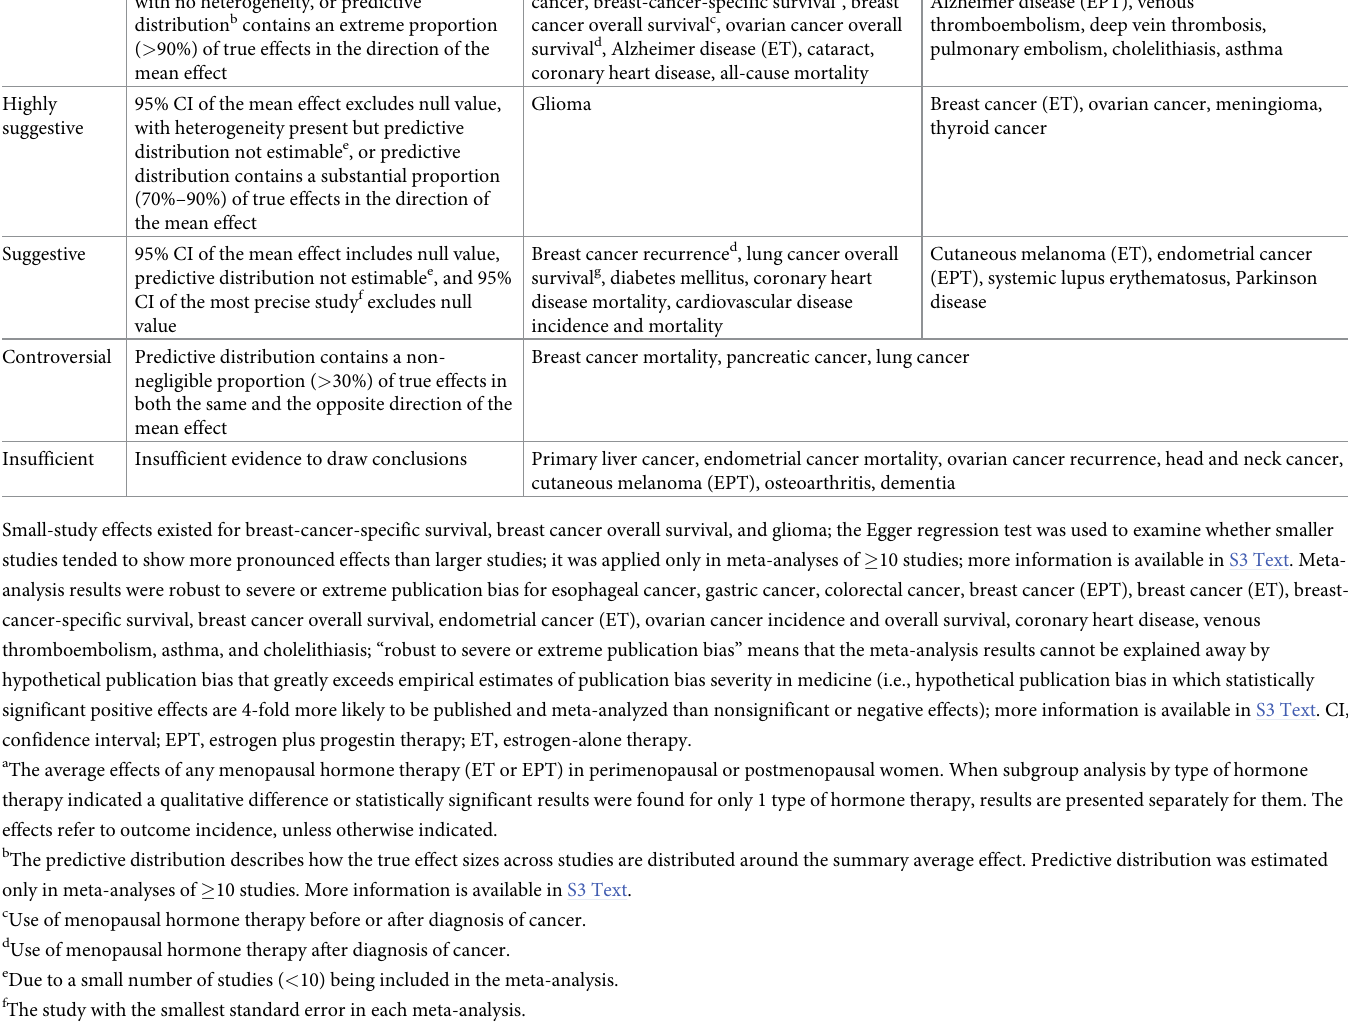
Table 2. Summary of evidence grading for meta-analyses of observational epidemiological studies on menopausal hormone therapy and incidence of diseases and other health outcomes. Evidence Criteria Meta-analyses of observational epidemiological studies a Outcomes with beneficial effects Outcomes with harmful